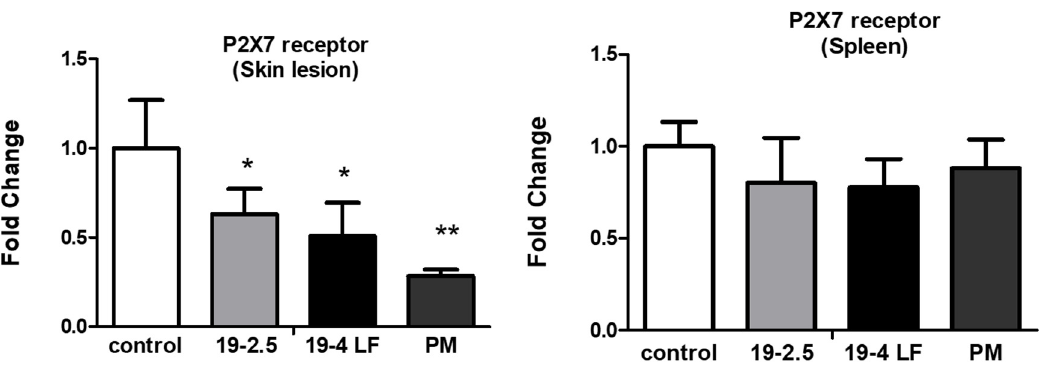
Figure 6. Effect of PM and the two peptides (19-2.5 and 19-4LF) on the expression levels of P2X7 receptor gene in the skin lesion and the spleen of treated BALB/c mice compared to untreated mice (controls). The bars represent the means ± SD. Significant differences were indicated (*, p < 0.05; **, p < 0.01 compared to controls).